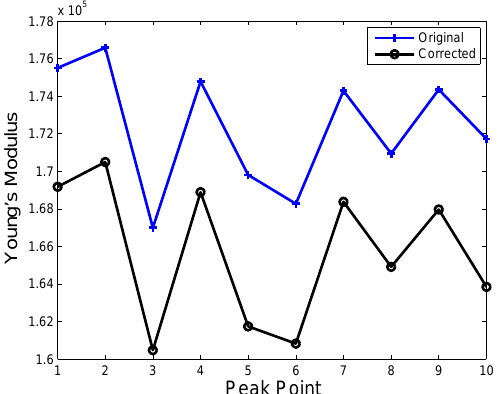
Figure 18. YM for the ’hard inclusion 8 mm beneath the surface’ case. The blue curve denotes the YM by original force measured by sensor, and the black curve indicates the YM by compensated force.